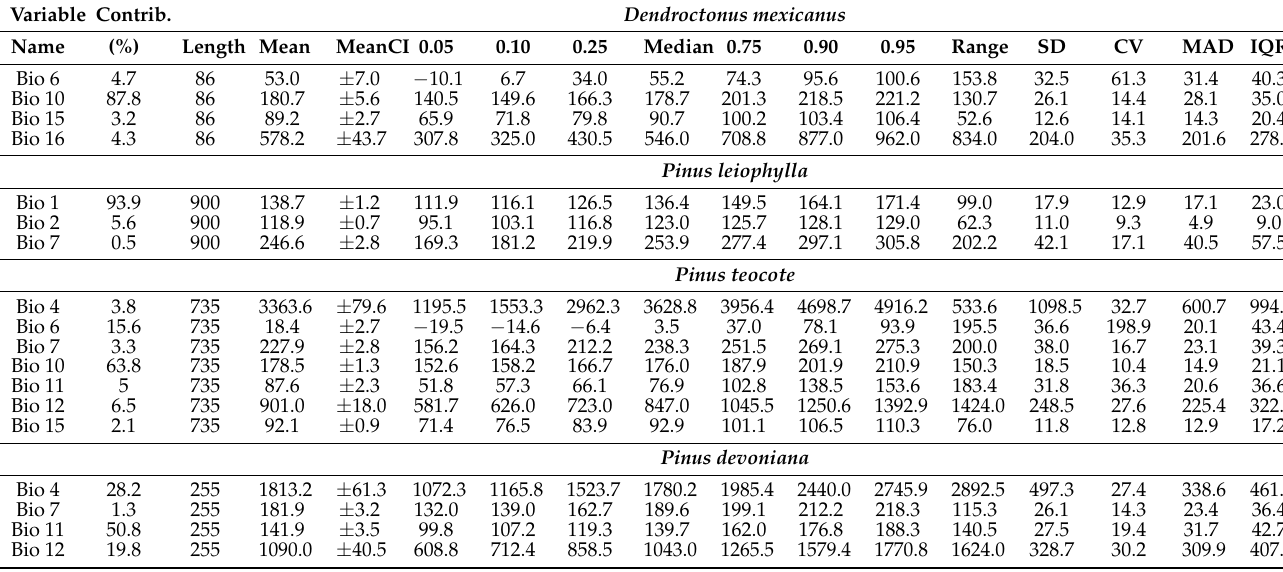
Table 3. Relative contribution (in percentage) of the suitability model bioclimatic variables of each species determined by the jackknife test and the detailed bioclimatic profile of the species. Variable Contrib.